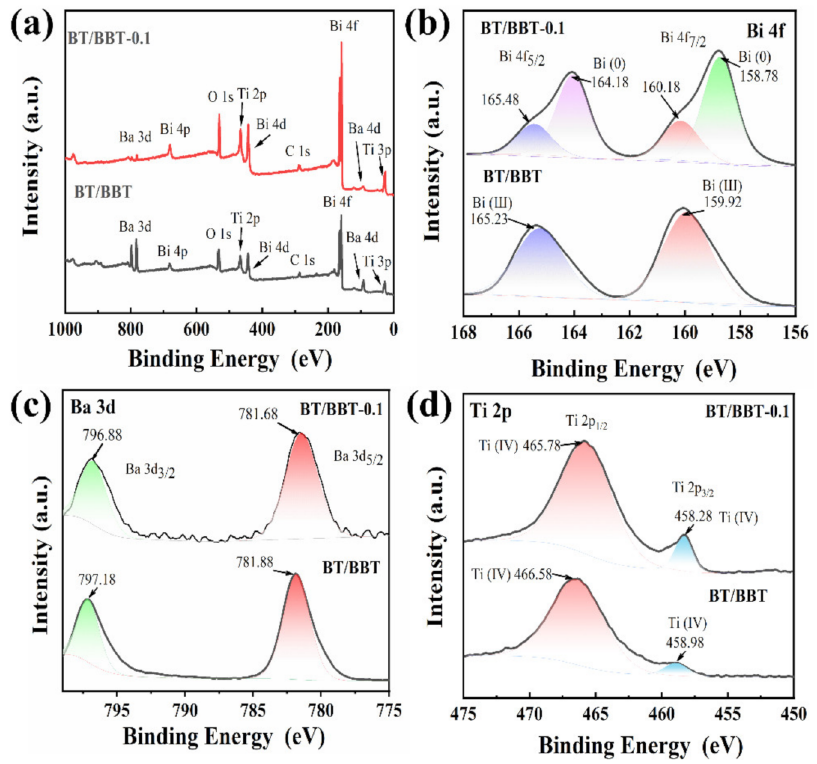
Figure 5. XPS spectra of ( a ) the overall survey, ( b ) Bi 4f ( c ) Ba 3d, and ( d ) Ti 2p on BT/BBT-0.1 and